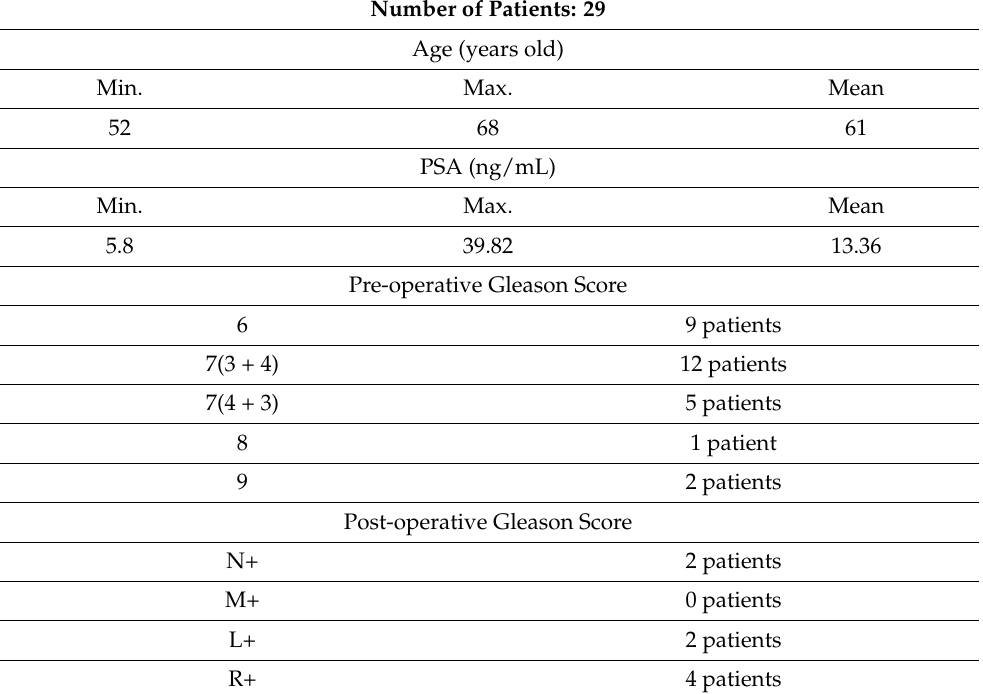
Table 1. Clinical data of patients